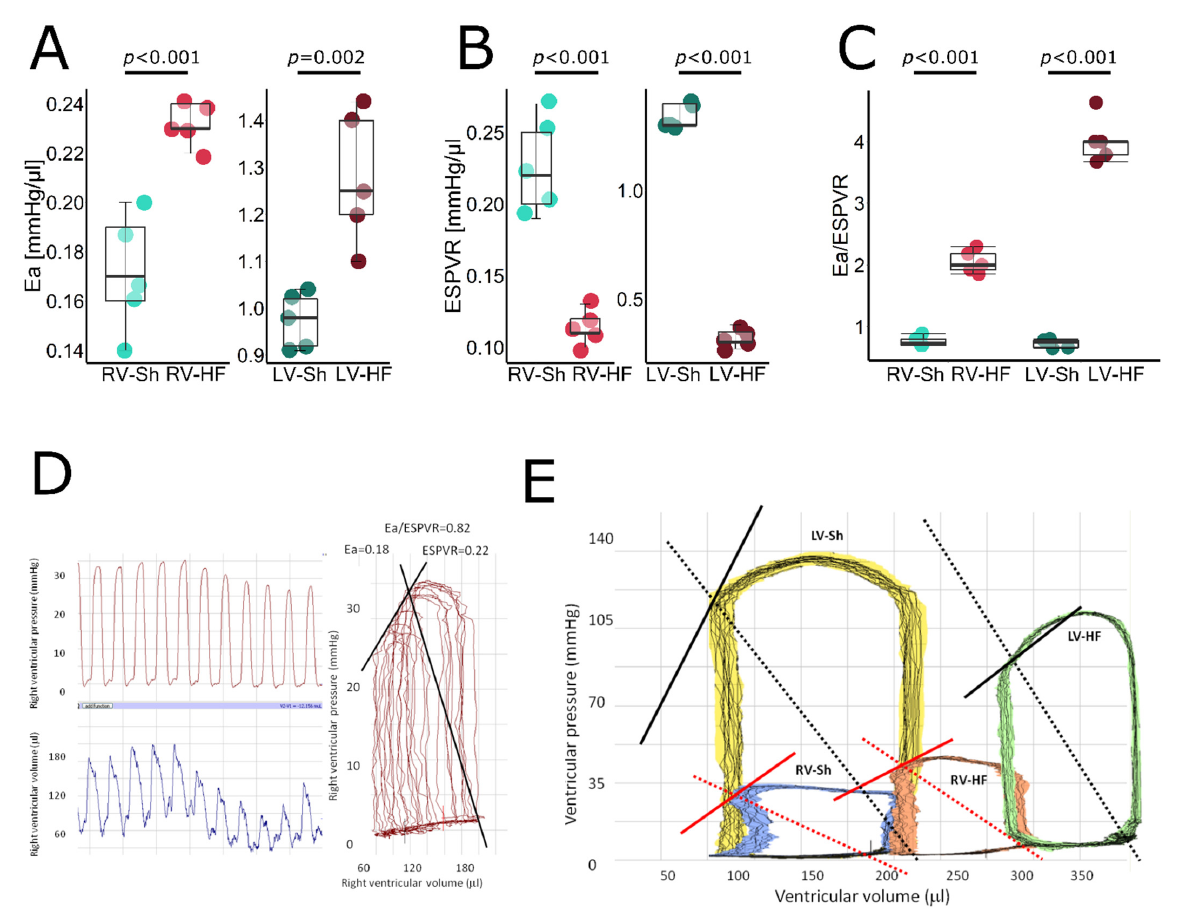
Figure 2. Pressure-volume loop analysis—stiffness, contractility and ventricular–arterial coupling in LV and RV of control and failing hearts. ( A ) Arterial elastance (Ea), ( B ) end-systolic pressure-volume relation (ESPVR), ( C ) ventricular-arterial coupling index (Ea/ESPVR), ( D ) representative LV pressure signals (left upper panel), LV volume signals (left lower panel) and reconstructed pressure-volume loops from these signals (right panel) from a sham-operated rat. ( E ) Representative pressure-volume loops obtained from (left to right) left ventricle of sham-operated rats (the yellow loop), right ventricle of sham-operated rats (blue loops), right ventricle of failing heart (orange loop) and left ventricle of failing heart (green loop). Solid line represents ESPVR, dashed line represents Ea. Data presented as median, Q1, Q3, max and min values.